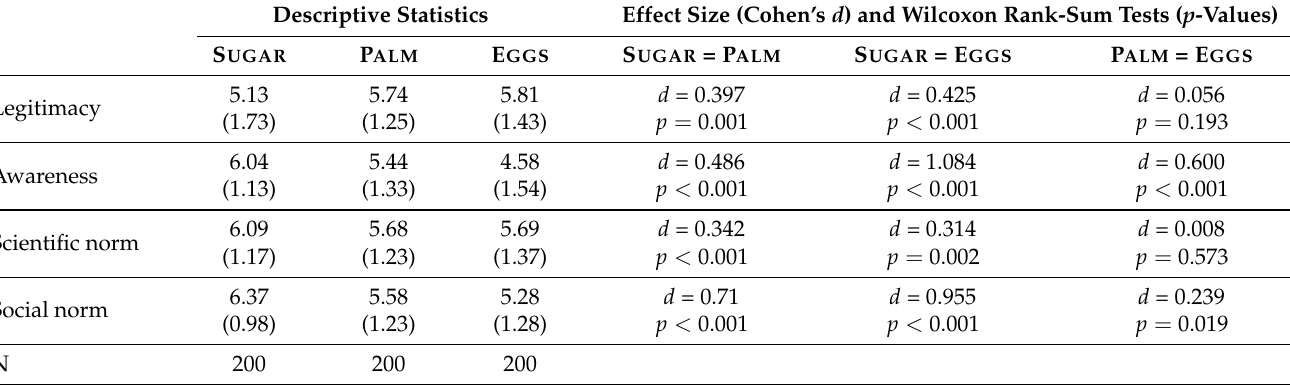
Table 4. Descriptive statistics for topic-level